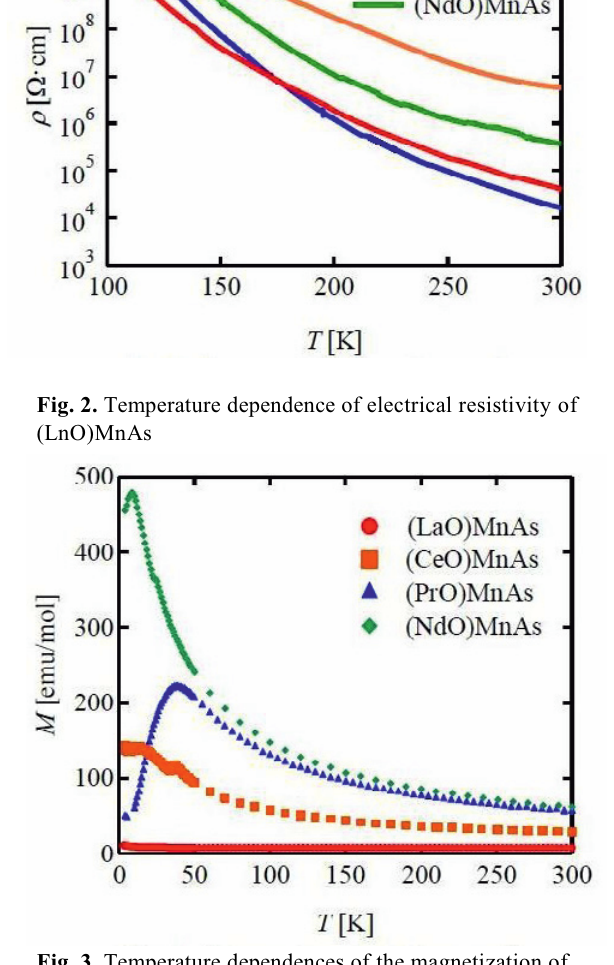
Fig. 3. Temperature dependences of the magnetization of